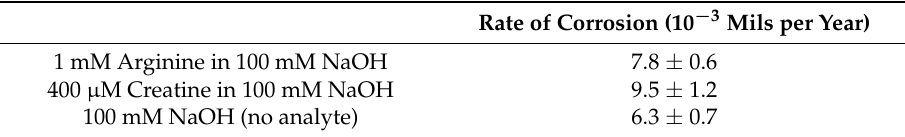
Table 1. Effect of 1 mM arginine in 100 mM NaOH on corrosion of fresh NiO surfaces.